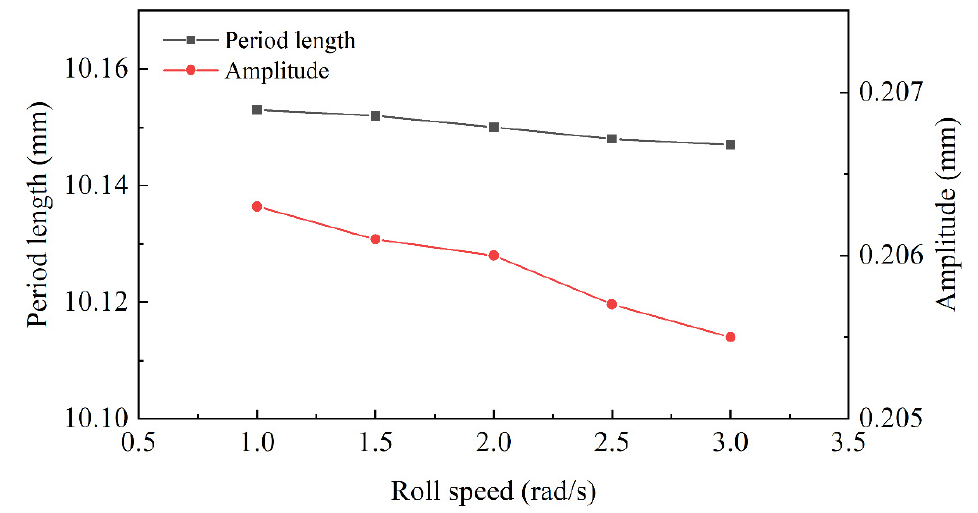
Figure 11. The morphology curve with different roll speeds.